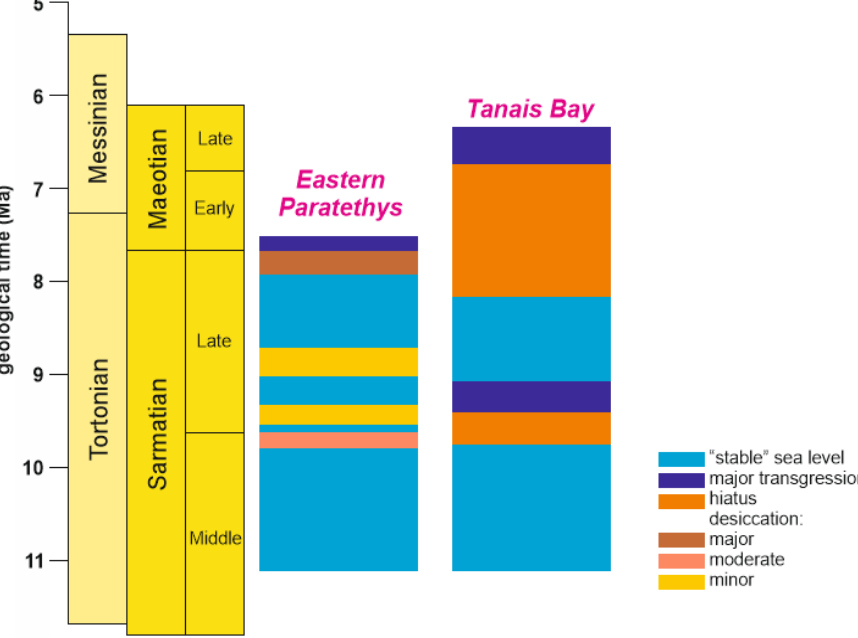
Figure 5. Correlation of the desiccation episodes in the Eastern Paratethys Sea (created by the author; the interpretations for the Eastern Paratethys are based on [6], and they are restricted to the time frame considered in the cited work; see Figure 2 for the stratigraphical framework).